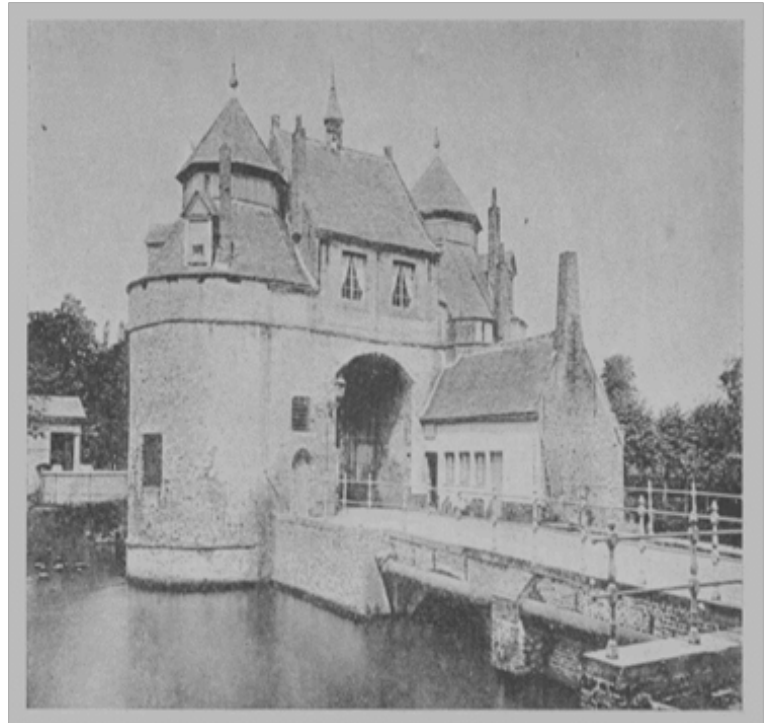
Figure 2. Anonymous. Photograph of Ezelpoort in Bruges La Morte (1892)